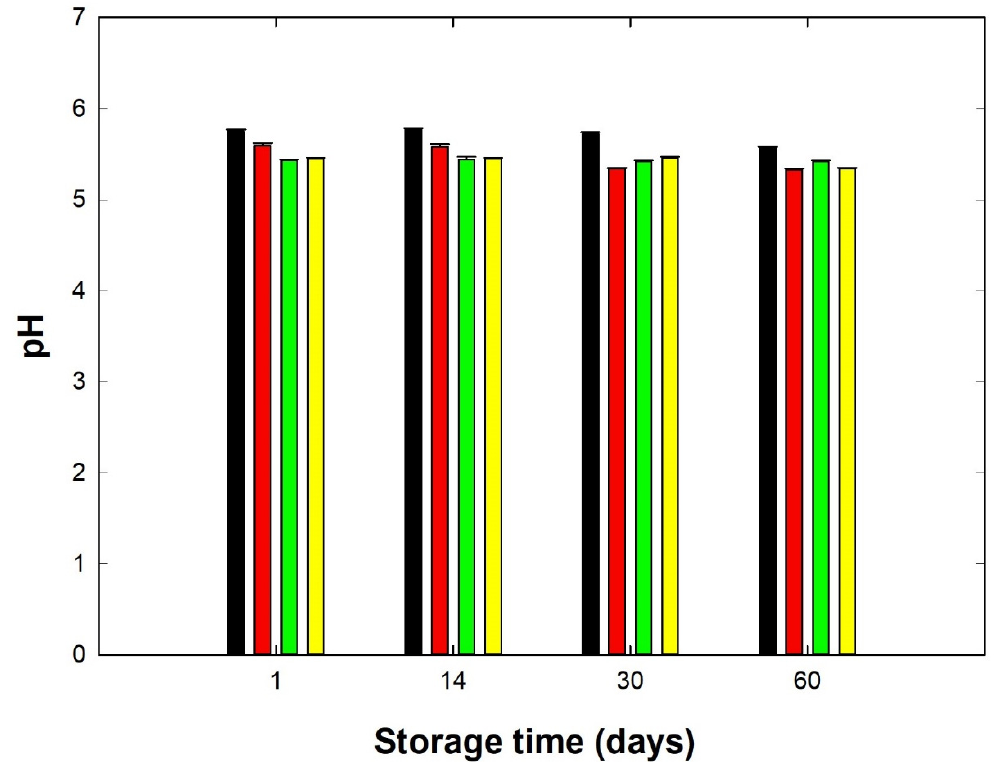
Figure 1. Development of pH values for processed cheese samples manufactured with different types of hydrocolloids: [control sample (black), agar (red), κ -carrageenan (green), and gelatin (yellow)] during a storage period of 60 days at 6 ± 2 °C [ n = 9; the results were expressed as means (columns) and standard deviations (bars); processed cheese samples were sampled after 1, 14, 30 and 60 days of storage].